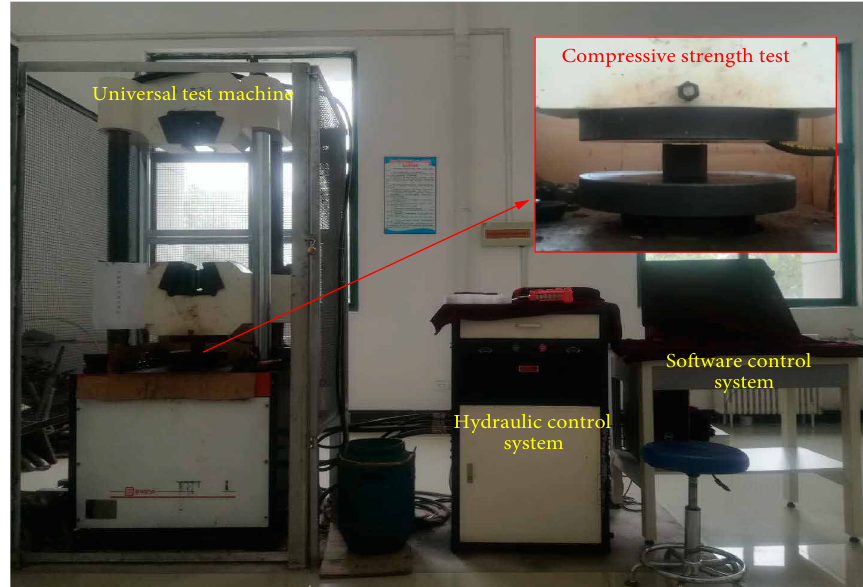
Figure 6: Diagram of compressive strength device used for testing the resin anchorage agent.